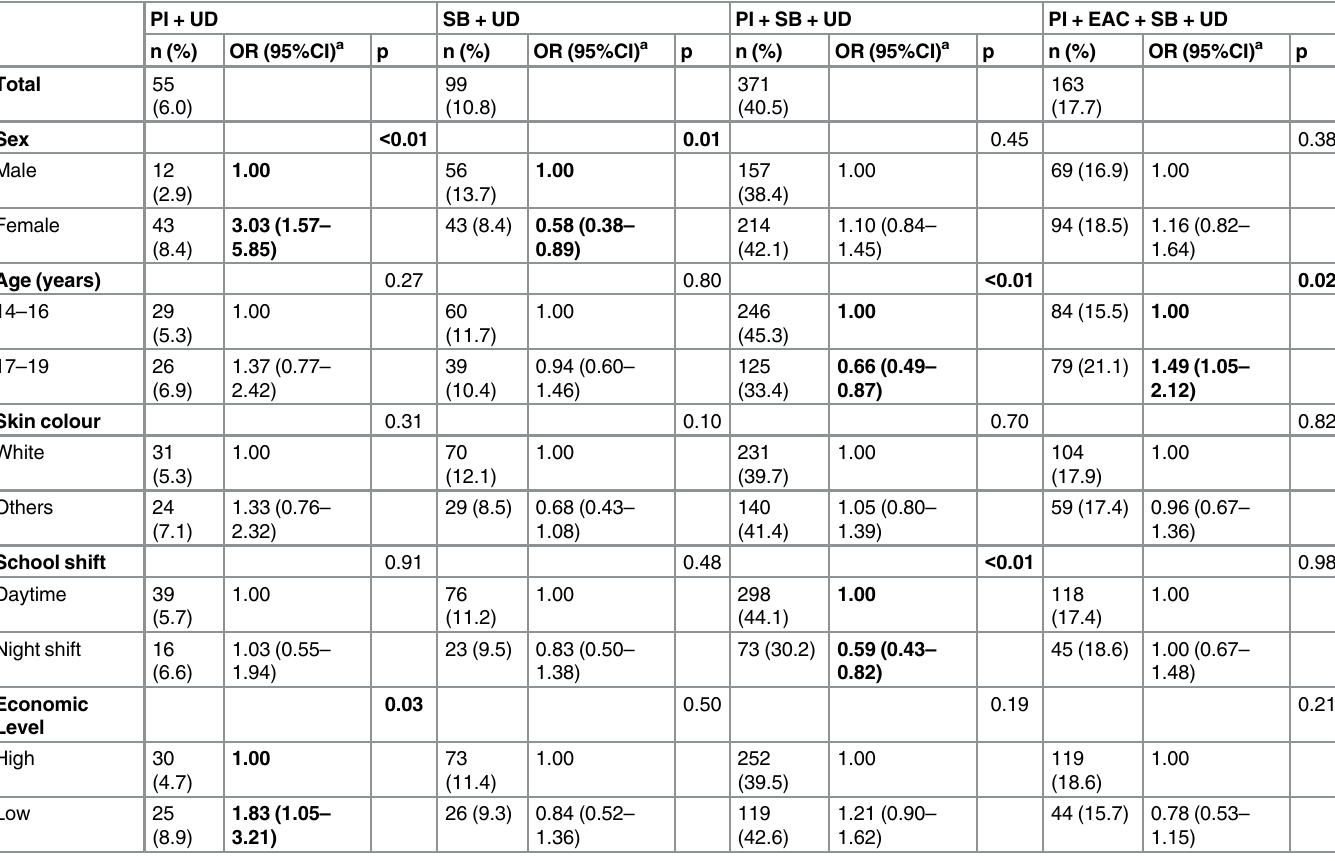
Table 5. Association between combinations of health risk behaviors most prevalent and demographic and socioeconomic variables in adolescents. PI +